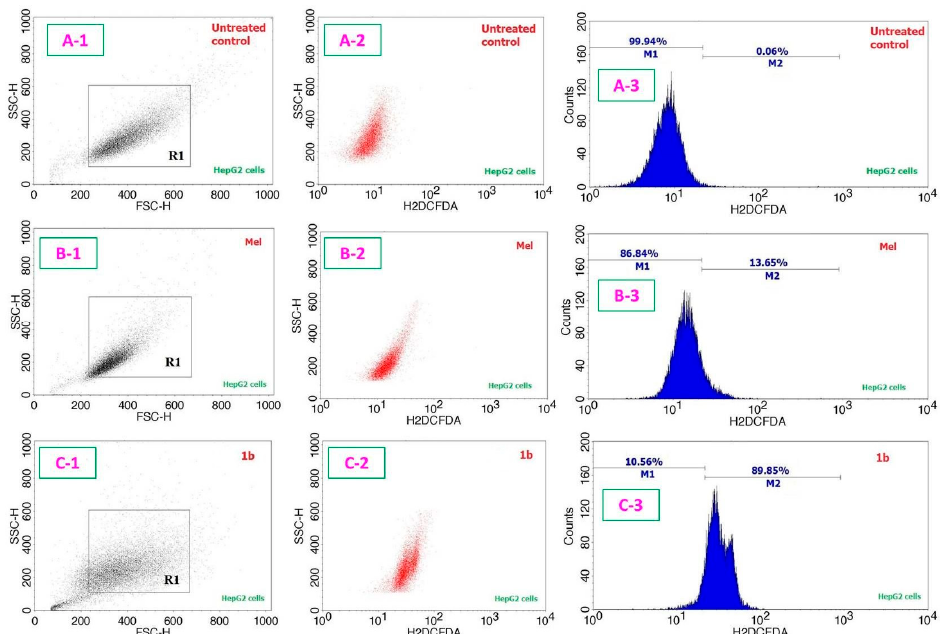
Figure 6. Comparison of flow cytometric analysis results for ROS generation in HepG2 cancer cells at 48 h incubation. From the figure, A, B, and C correspond to the negative control (without any treatment), the positive control (Mel; 15 μ g/mL), and compound 1b (at IC 50 ), respectively, while 1, 2, and 3 stand for the cell population tested, number of cells exhibiting H 2 DCFDA fluorescence, and % of fluorescent intensity, respectively.